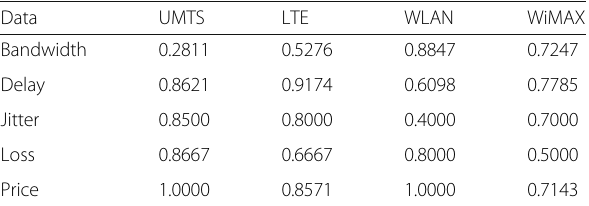
Table 21 Utility values of attributes for data application in default parameter settings